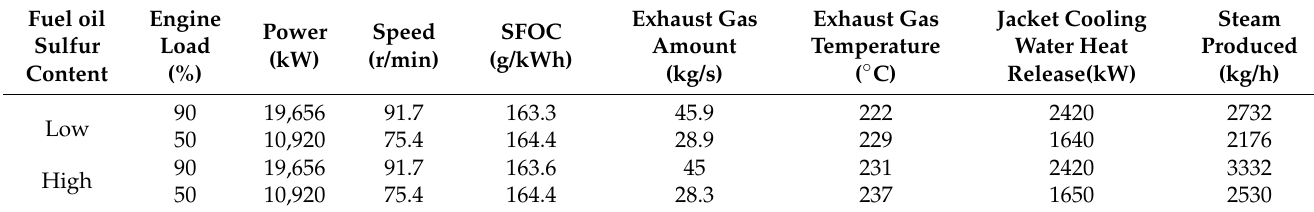
Table 2. Main engine operating parameters.